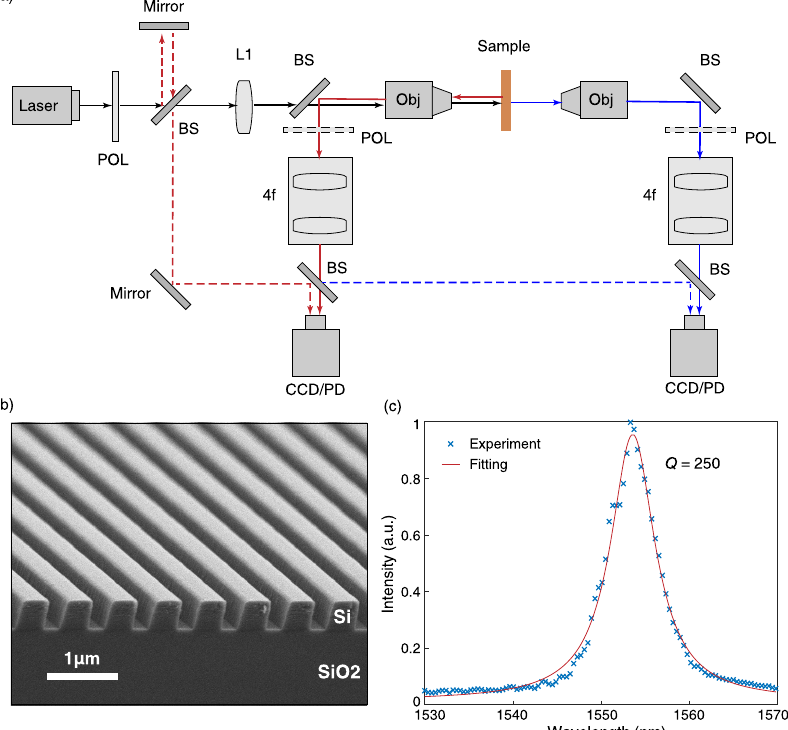
Figure 3: The experimental setup and sam- ple